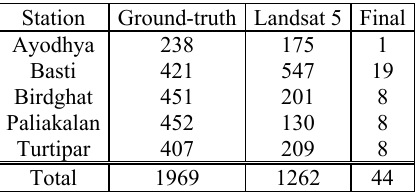
Table 2. Number of measurements used in this research